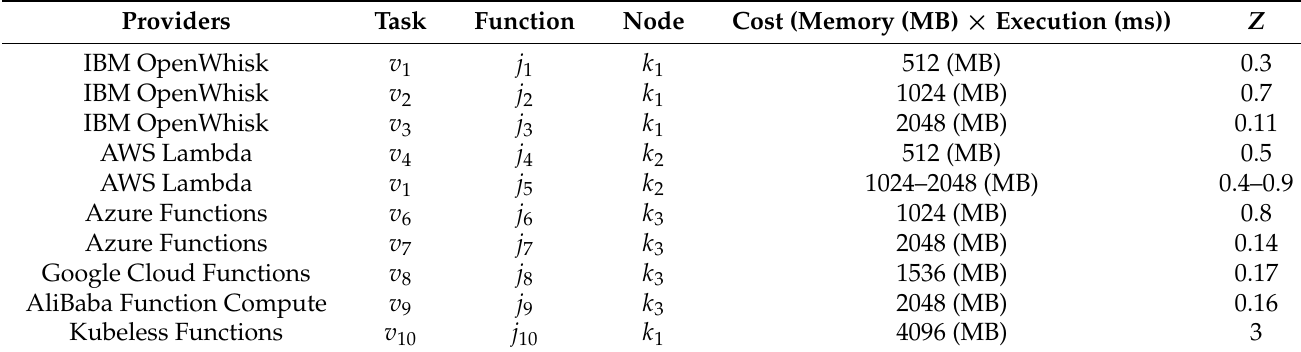
Table 5. Function of Different Vendors.